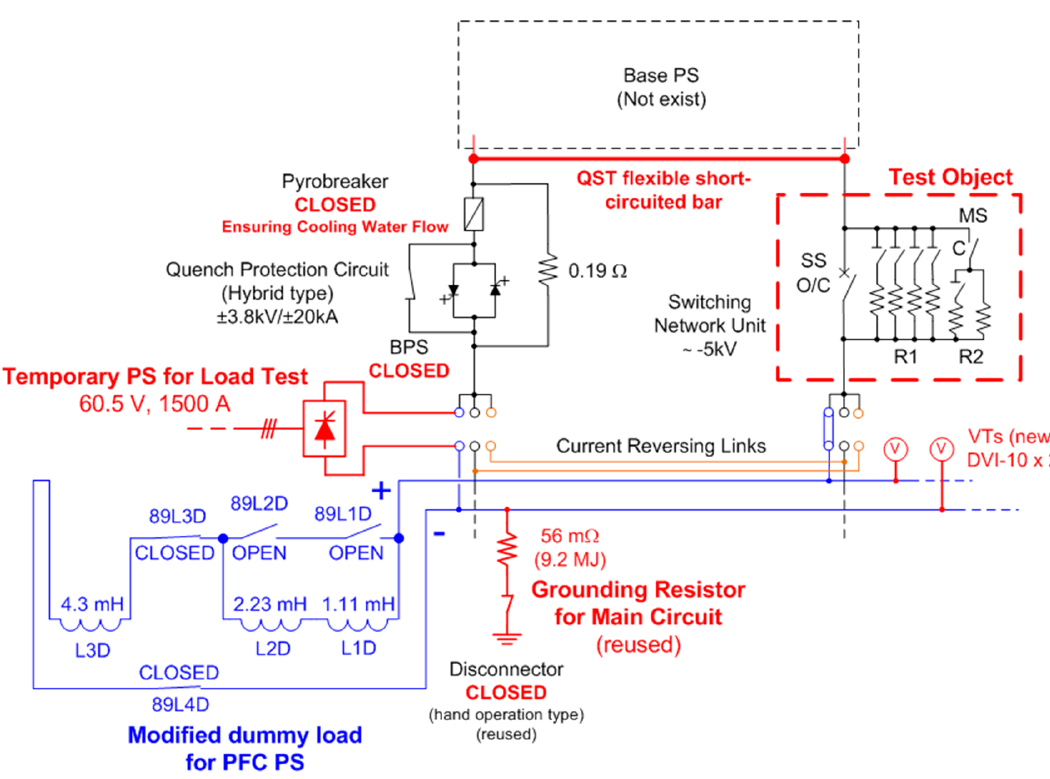
Figure 7. Schematic circuit of the set-up for the on-site tests of the SNU (denoted as Test Object). Since the JT-60SA CS was still not available, the PS circuit was connected to a proper dummy load.